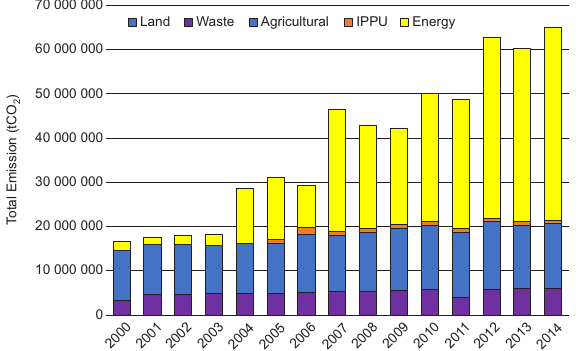
Fig. 3. Increasing trends of carbon dioxide emission form all sectors in Surakarta City (Kementerian lingkungan Hidup dan Kehutanan Indonesia 2016).